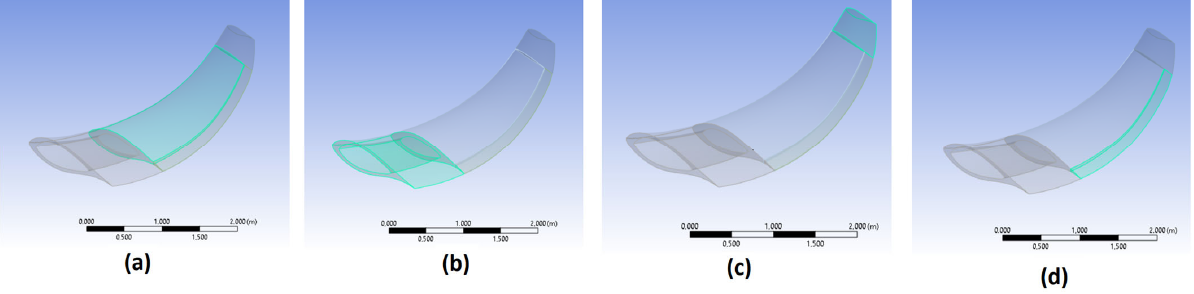
Figure 7. Geometry segmentation for TO facilitation. ( a ) Main body region, ( b ) hollow base for assembly, ( c ) bladelet tip region, ( d ) trailing edge region.